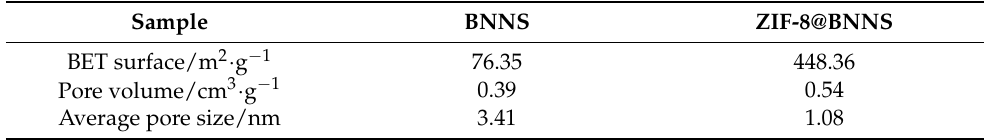
Figure 5. Nitrogen adsorption–desorption curve of ZIF-8@BNNS composite materials. Table 2. BET data of BNNS and ZIF-8@BNNS.